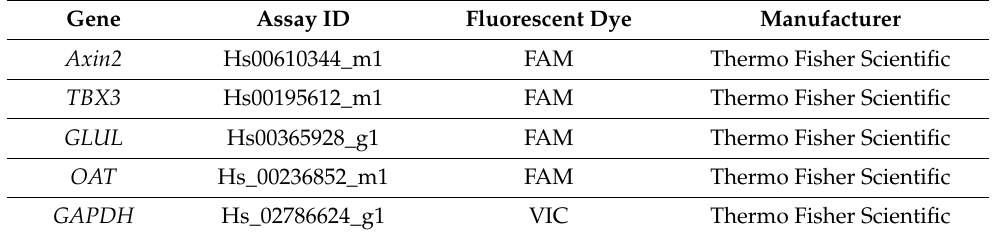
Table 2. List of TaqMan ® probes used for quantitative real-time